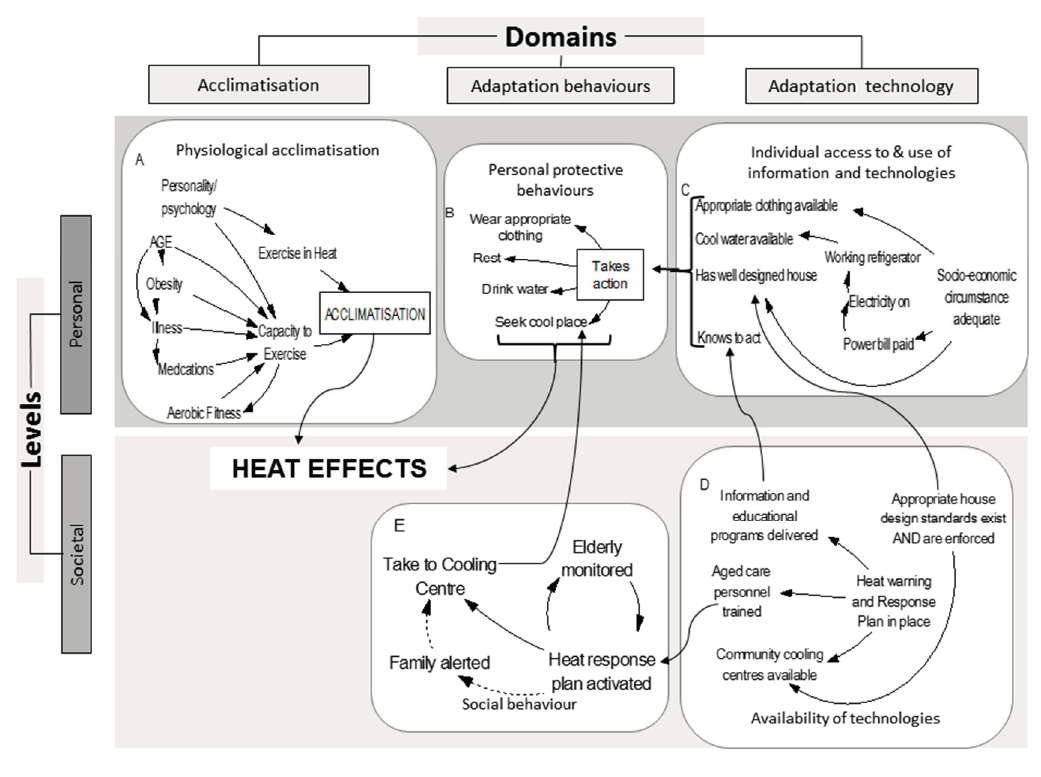
Figure 5. Heat response across scales. The figure models elements that contribute to planning to prevent adverse heat effects on elderly people. Different levels of government would act at the level where their influence would be most